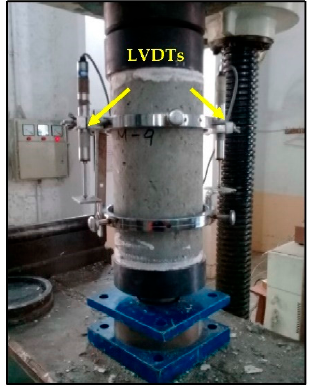
Figure 3. Experimental configuration for determination of compressive strength, stress–strain rela- tionship, and modulus of elasticity.